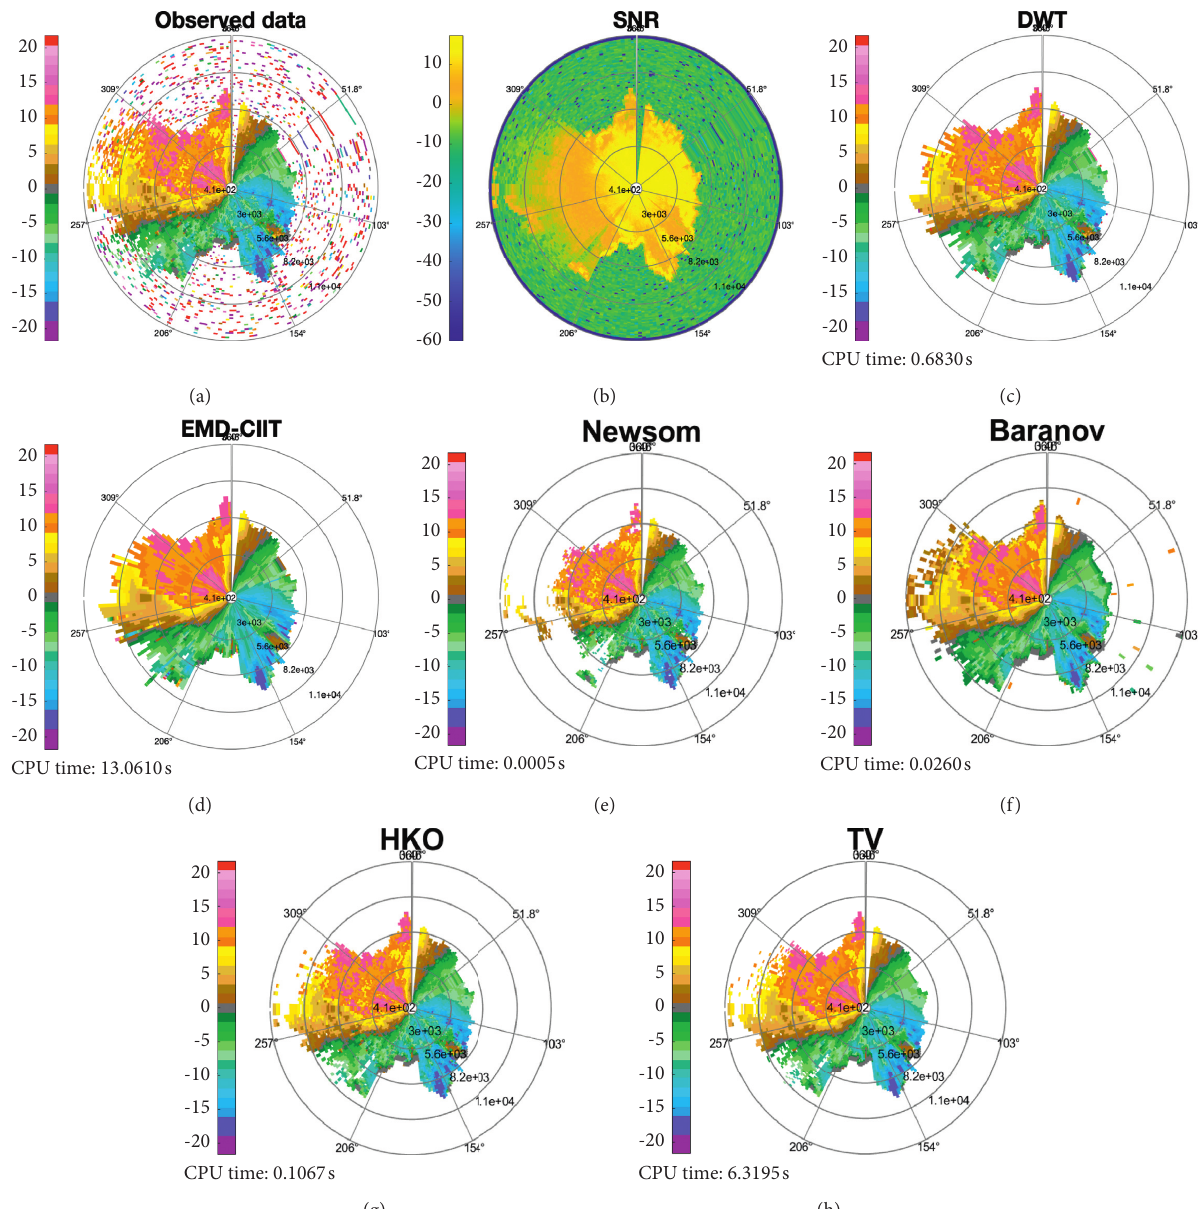
Figure 8: (a) The LiDAR data and (b) SNR values collected on 5 March 2015 from 04:16:02 to 04:16: 25. The denoising results by (c) the “DWT” method, (d) the “EMD-CIIT” method, (e) the “Newsom” method, (f) the “Baranov” method, (g) the HKO method, and (h) the proposed scheme (denoted by